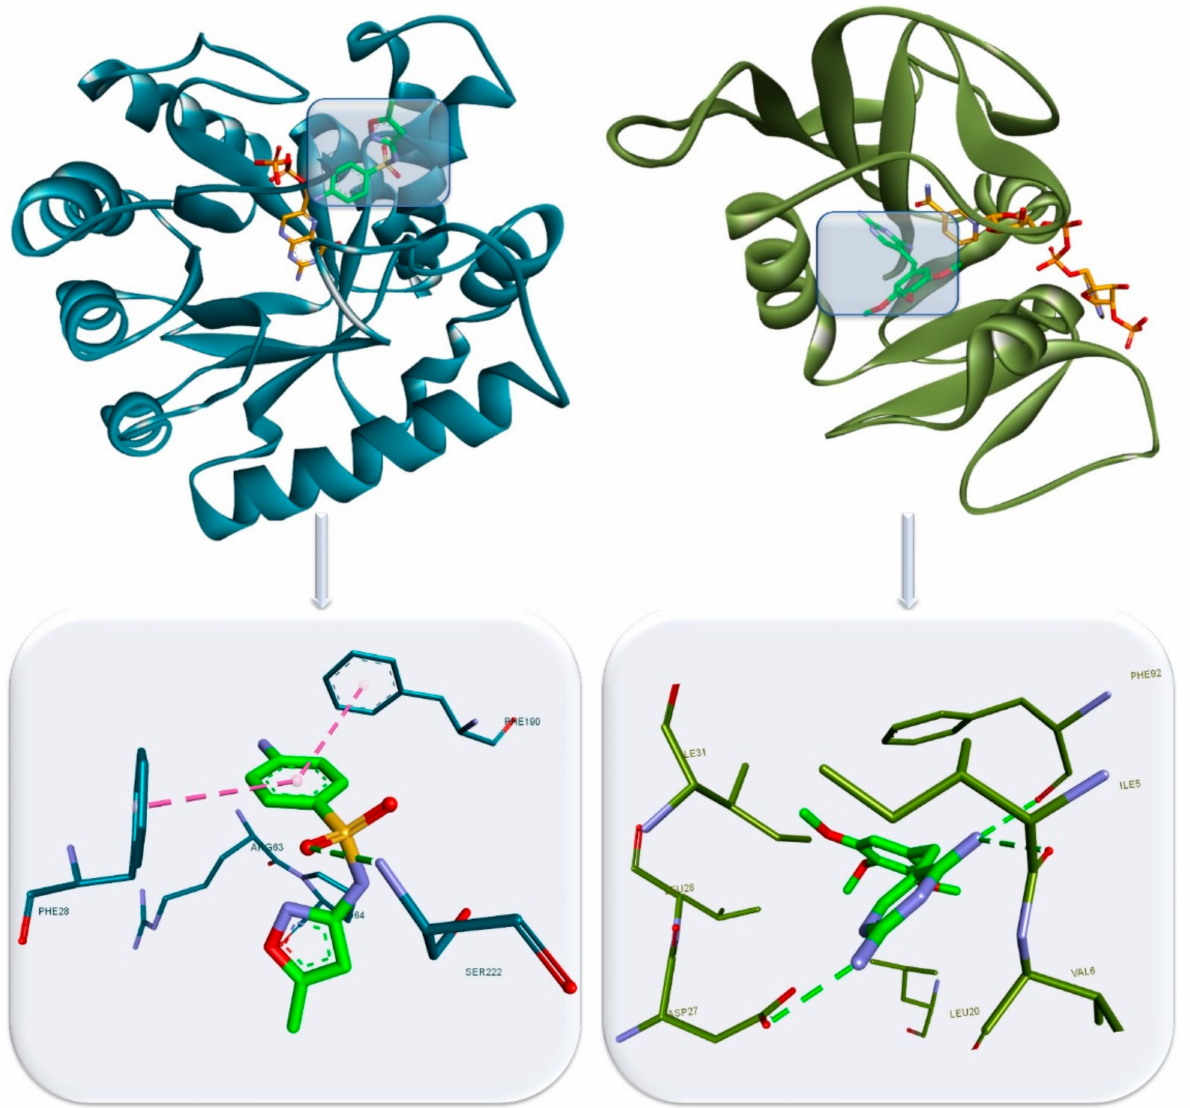
Figure 7. Dihydrofolate reductase chain A (right) from S. aureus in complex with trimethoprim (green) and NADPH (orange) and dihydropteroate synthase chain B (left) from Y. pestis in complex with sulfamethoxazole (green) and 6- hydroxymethylpterin-diphosphate (orange). The figure was built with Biovia Discovery Studio 4.1 using the PDB entries 3TZF and 2W9S